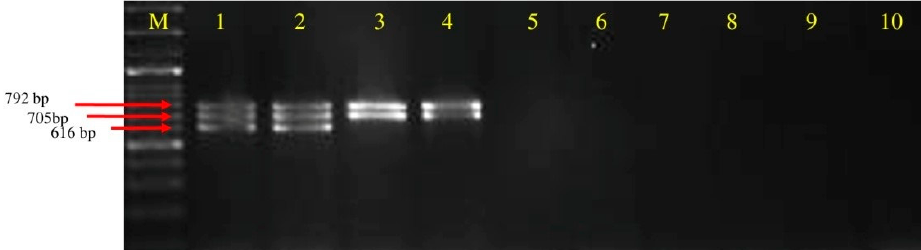
Figure 2. Simultaneous amplification of three polyketide antibiotic synthase genes i.e., difficidin, macrolactin and bacillaene of Bacillus at 705 bp, 792 bp and 616 bp using multiplex—PCR for primer specificity, respectively. Lane 1; M. 100 bp DNA Ladder: Lane 1: B. amyloliquefaciens DSBA-11;